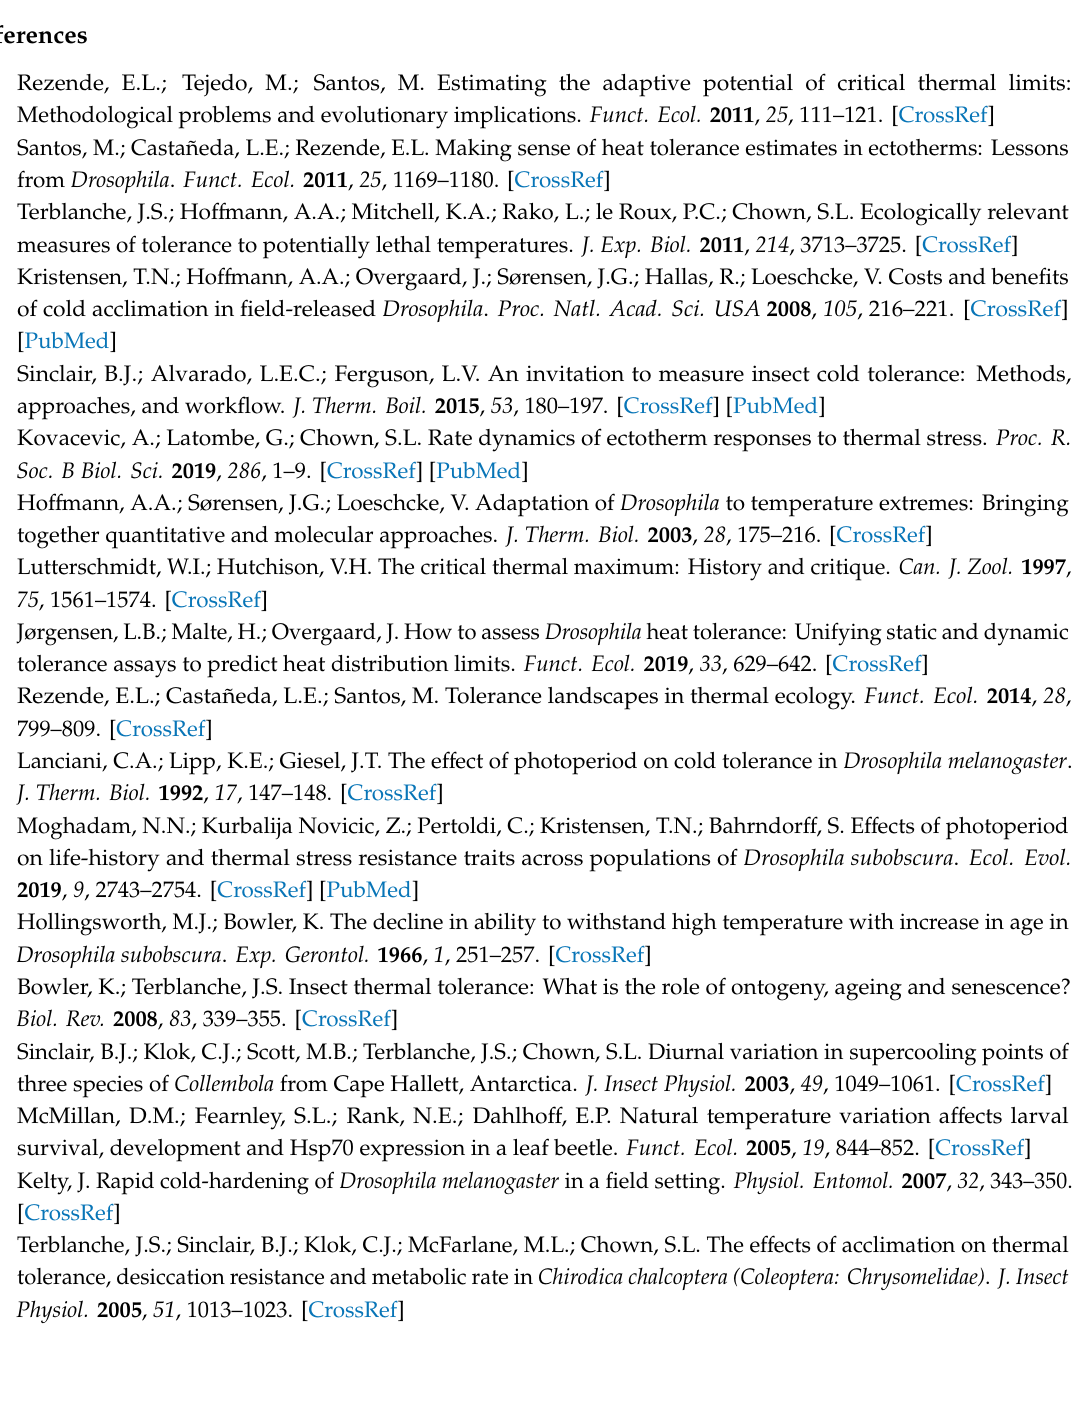
Table S1: contains information about the 10 species investigated. Table S2: contains raw data before and following the MAD exclusion used for analysis in this